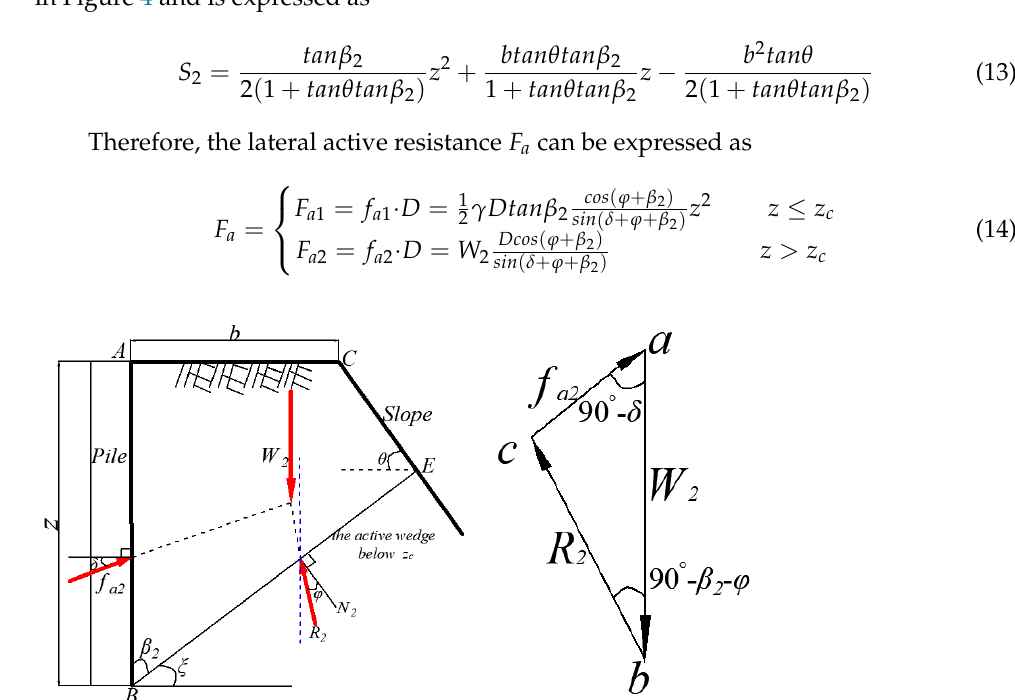
Figure 4. Post-pile active wedge failure mode below critical depth 𝑧 (cid:3030) and the system of forces,